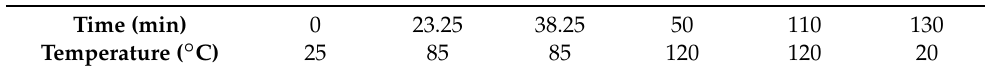
Table 4. Resin curing cycle.